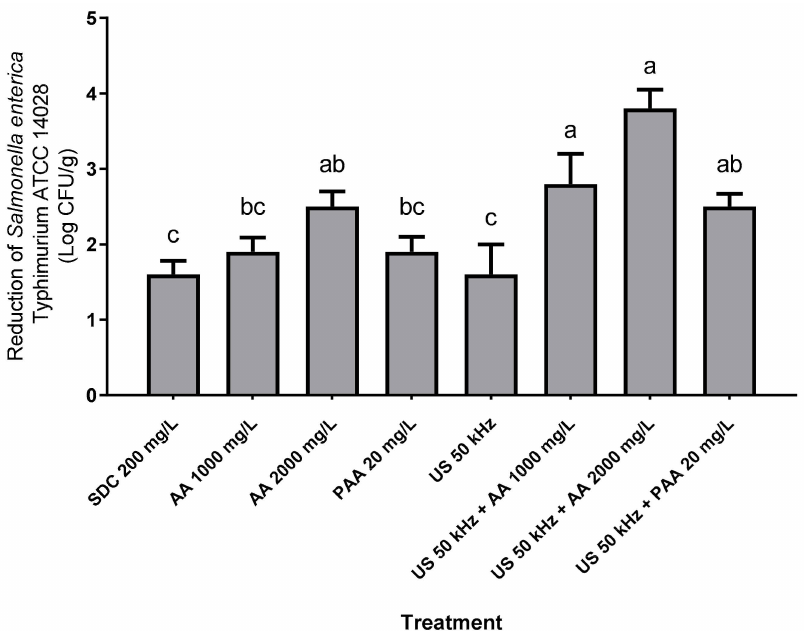
Figure 2. Decimal reductions in the count of Salmonella enterica Typhimurium ATCC 14028 (log CFU/g) adhered to the surface of kale compared with the non-sanitized sample. Treatments (columns) with the same letter do not differ significantly by Tukey’s test after three replications ( p > 0.05). SDC: sodium dichloroisocyanurate; AA: acetic acid; PAA: peracetic acid; US: